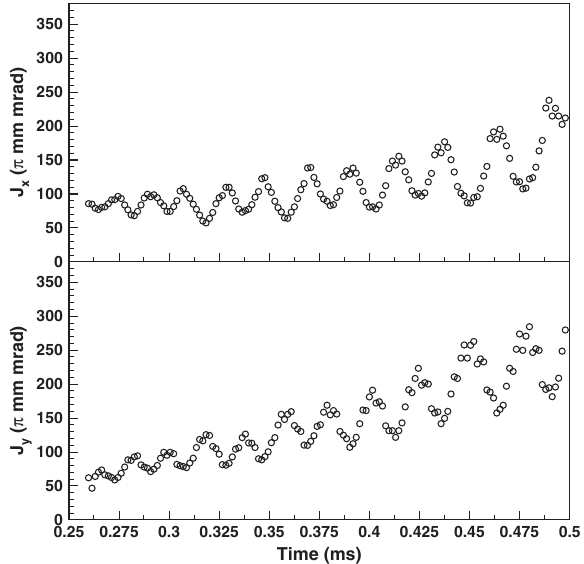
FIG. 15. Two-dimensional plot of the turn-by-turn betatron actions given in Fig.